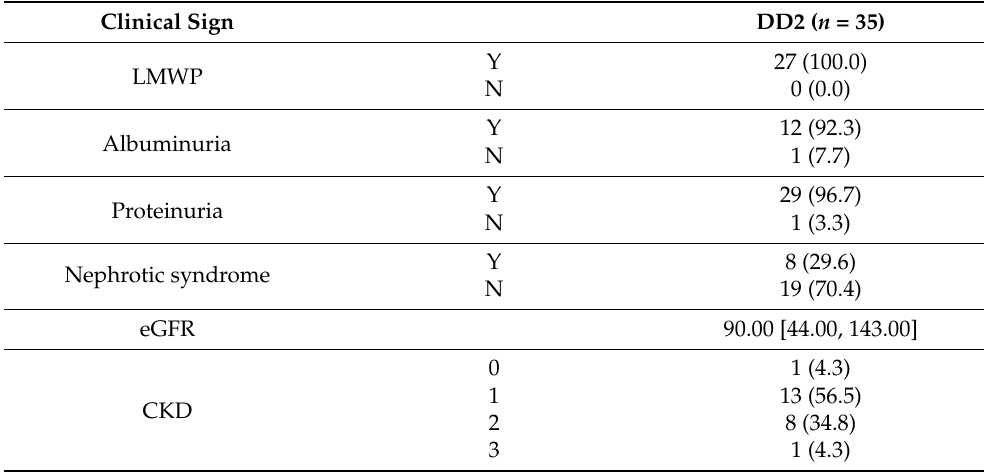
Table 1. Clinical signs of the 35 Dent disease type 2 (DD2) subjects enrolled. Continuous vari- ables were reported as median [Min, Max], categorical variables as number of cases (%). LMWP: Low-molecular-weight proteinuria, eGFR: estimated glomerular filtration rate, CKD: Chronic kidney disease, CNS: central nervous system, TRP: renal tubular reabsorption of phosphate, Y: present, N: